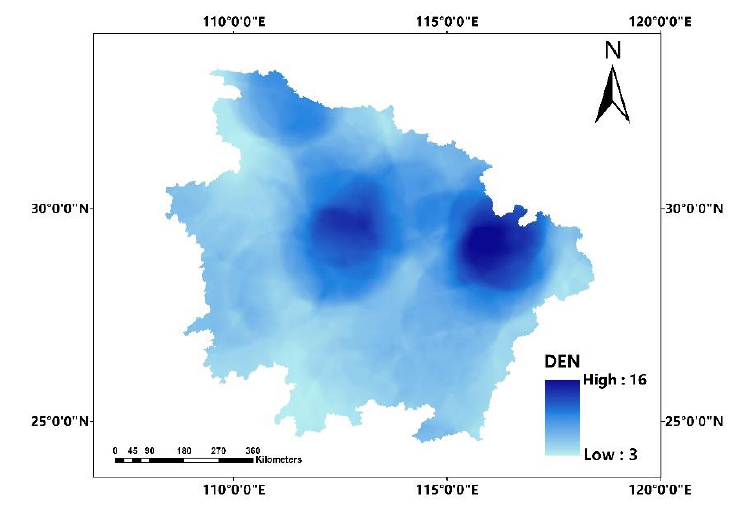
Figure 7. River Density.